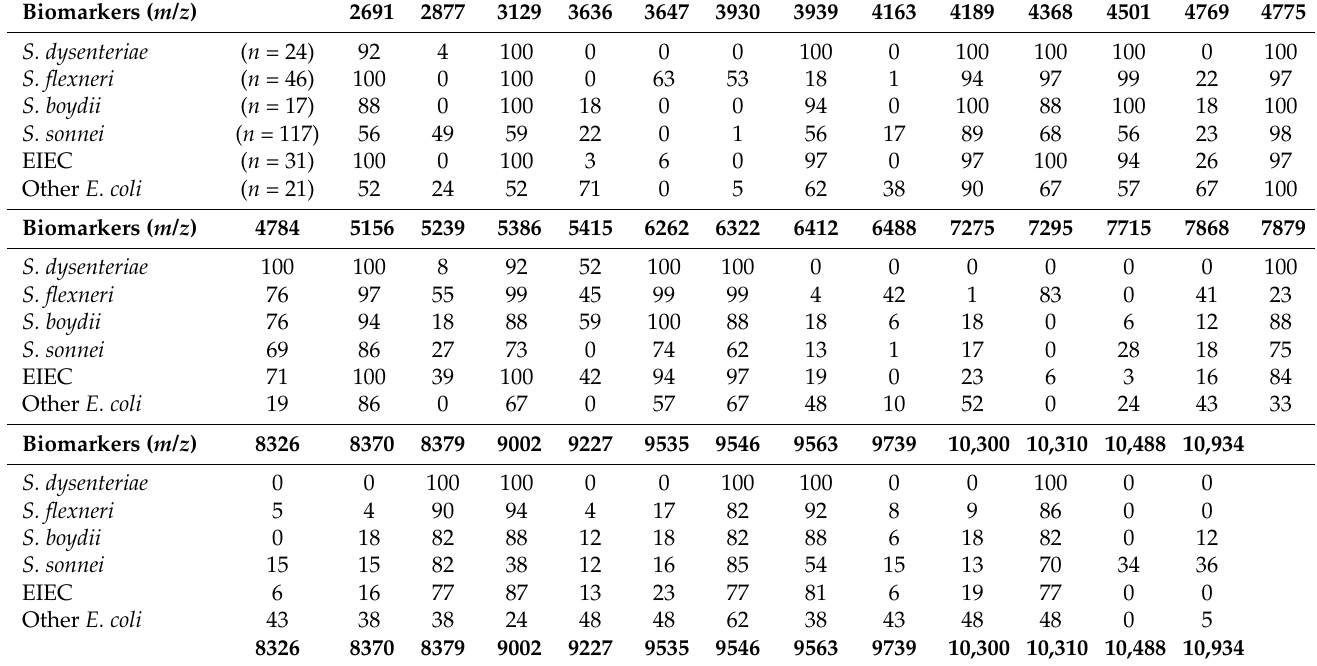
Table 2. Discriminationschemeofbiomarkers, percentageofisolatesinthetrainingsetwithspecificbiomarkers. Biomarkers ( m / z